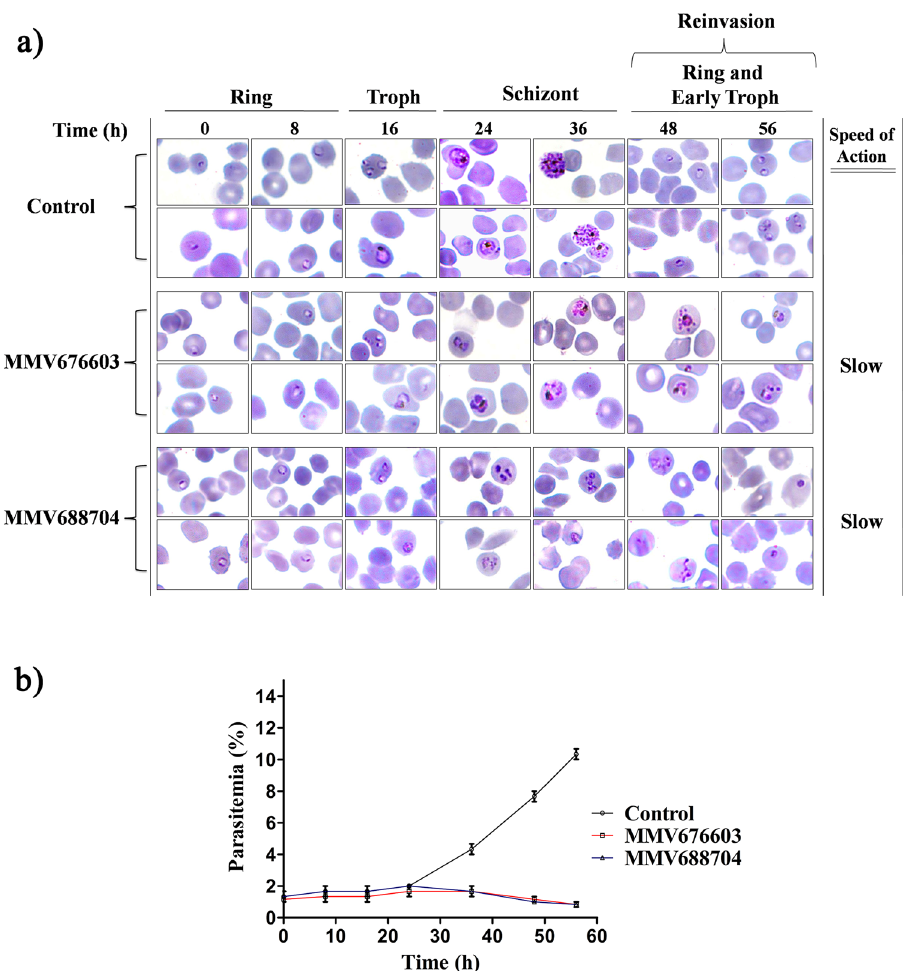
Figure 8. Effect of MMV676603 and MMV688704 on the growth and morphology of intraerythrocytic stage of P. falciparum , and assessment of their speed of action: synchronized P. falciparum 3D7 culture was treated with leads (MMV676603 and MMV688704) and their effect on parasite phenotype and growth was analyzed by ( a ) Giemsa stained blood smear micrographs at 0, 8, 16, 24, 36, 48 and 56 h (two representative images of each set). The speed of action of both the compounds (MMV676603 and MMV688704) was evaluated for one complete maturation cycle [starting from ring (0 h), trophozoite (16–24 h) to schizont (36 h)]. Both the compounds were considered as slow inhibitors as they hinder the parasite development at late stages (trophozoite and schizont). ( b ) The in-vitro reduction in parasitemia level was quantified and illustrated as a graph, indicating the parasitemia level as a function of parasite life cycle progression (time). Data are represented as Mean ±